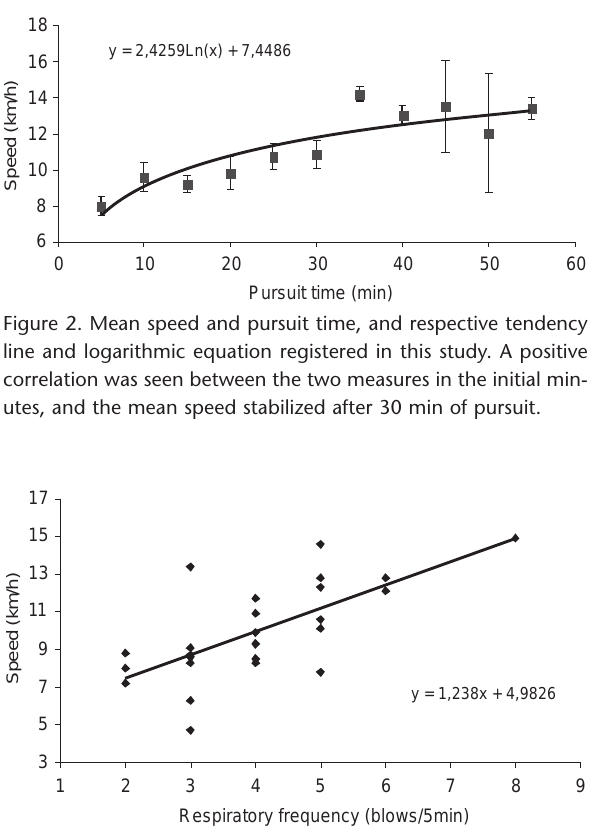
Figure 3. Positive correlation between speed and respiratory fre- quency of the humpback whales during this study, and respective tendency line and linear equation. The highest value observed for the respiratory frequency was 8 blows/5 min (1.6 blow/min), with a mean speed of 14.9